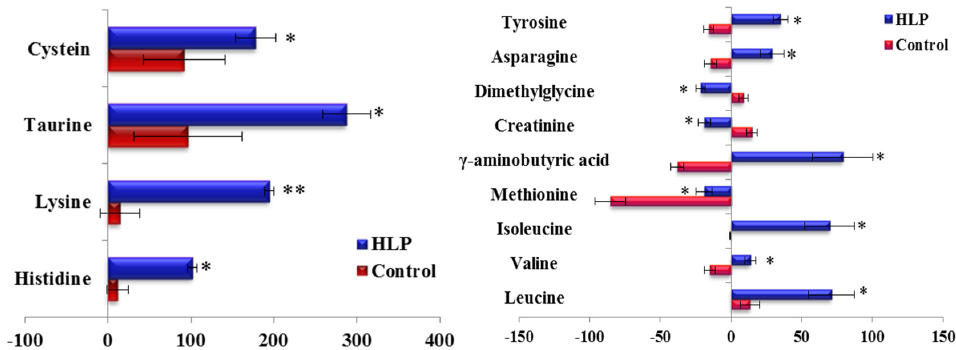
Figure 4. Percent change of metabolites from fasting to 2-h samples during an OGTT in the control (Blue) and HLP groups (Red). Percent changes for the metabolites (X) detected by UPLC-TQ-MS were calculated as follows: X Percent change = (X Concentration at different time (120) − X Concentration at baseline )/(X Concentration at baseline ). * p < 0.05, ** p < 0.01, compared with the control group using student’s t test.